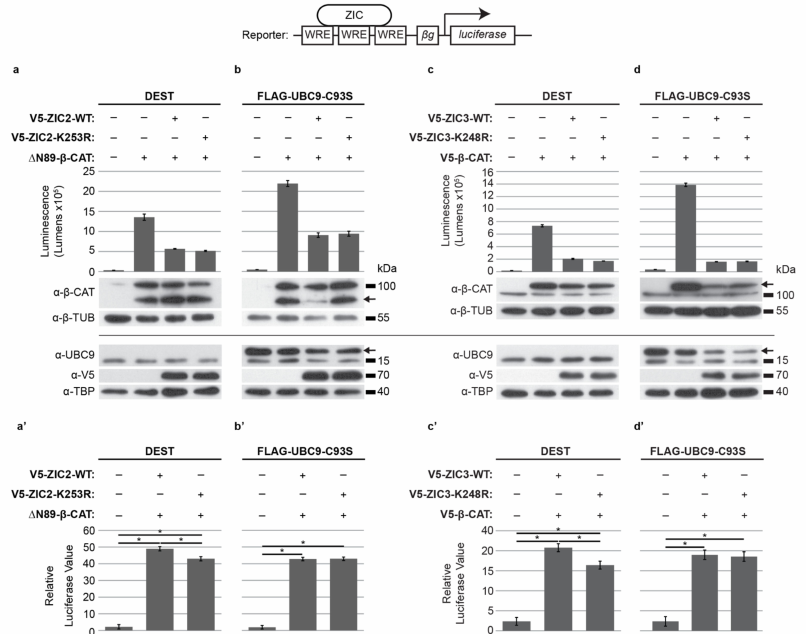
Figure 5. SUMOylation reduces ZIC inhibition of WNT signaling. Luciferase activity at the ZIC-optimized WRE reporter in HEK293T cells. ( a , a ’) The K253R SUMO-incompetent form of ZIC2 shows a significant increase in inhibition of β -catenin- mediated transcription compared to wild-type ZIC2. ( b , b ’) The ability of wild-type ZIC2 to inhibit β -catenin-mediated transcription is increased when SUMOylation is universally inhibited via UBC9-C39S and is equivalent to the SUMO- incompetent form of ZIC2. ( c , c ’) The K248R SUMO-incompetent form of ZIC3 shows a significant increase in inhibition of β -catenin-mediated transcription compared to wild-type ZIC3. ( d , d ’) The ability of wild-type ZIC3 to inhibit β -catenin- mediated transcription is increased when SUMOylation is universally inhibited via UBC9-C39S and is equivalent to the SUMO-incompetent form of ZIC3. ( a – d ) Raw data and WB showing overexpressed proteins from one representative experiment. For WB of cytoplasmic fractions (using antibody against β -catenin; α - β -CAT), antibody against β -tubulin ( α - β -TUB) was used as a loading control. The arrow in the α - β -CAT WB ( a – c ) denotes the tagged exogenous protein (V5- β -CAT is larger and ∆ N89- β -CAT is smaller than the endogenous β -CAT). For WB of nuclear fractions (using antibodies against V5 or UBC9) antibody against TBP was used as a loading control. The arrow in the UBC9 WB denotes the larger, tagged exogenous protein. Error bars denote ± s.d. from three internal repeats. ( a ’– d ’) Pooled data from three external repeats (normalized to background). Error bars denote ± s.e.m. *: p < 0.05, two-way ANOVA with Bonferroni multiple comparison